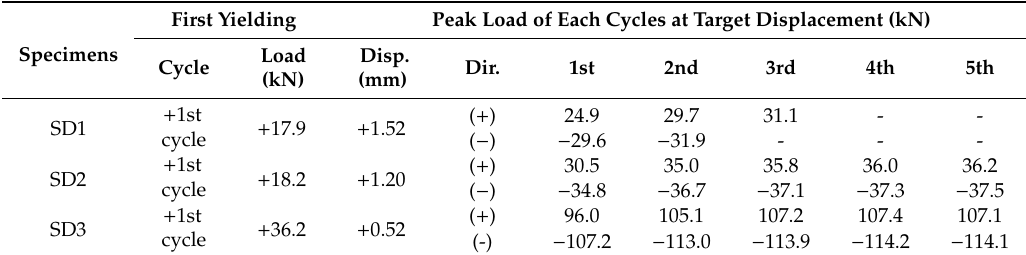
Table 2. Experimental results of tested specimens.